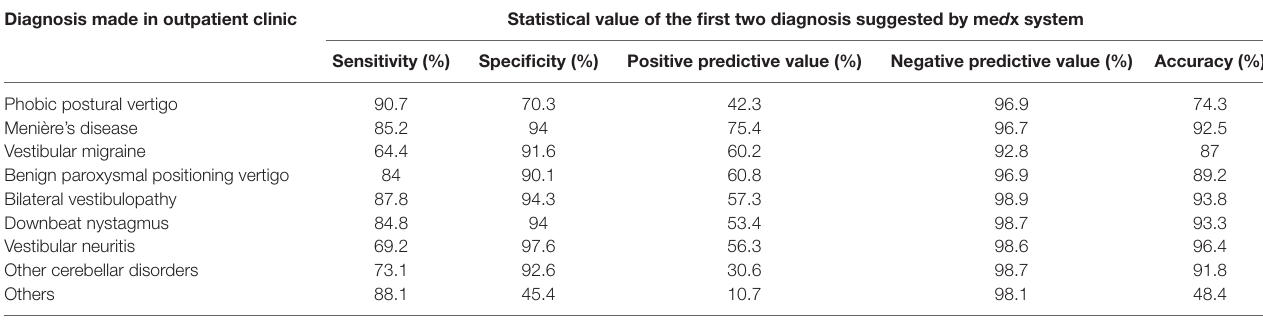
TaBle 5 | Statistical value analyzing me d x system in a one-class problem and taking into consideration the first two diagnoses suggested by the me d x system. Diagnosis made in outpatient clinic statistical value of the first two diagnosis suggested by me d x system sensitivity (%) specificity (%) Positive predictive value (%) negative predictive value (%) accuracy (%) Phobic postural